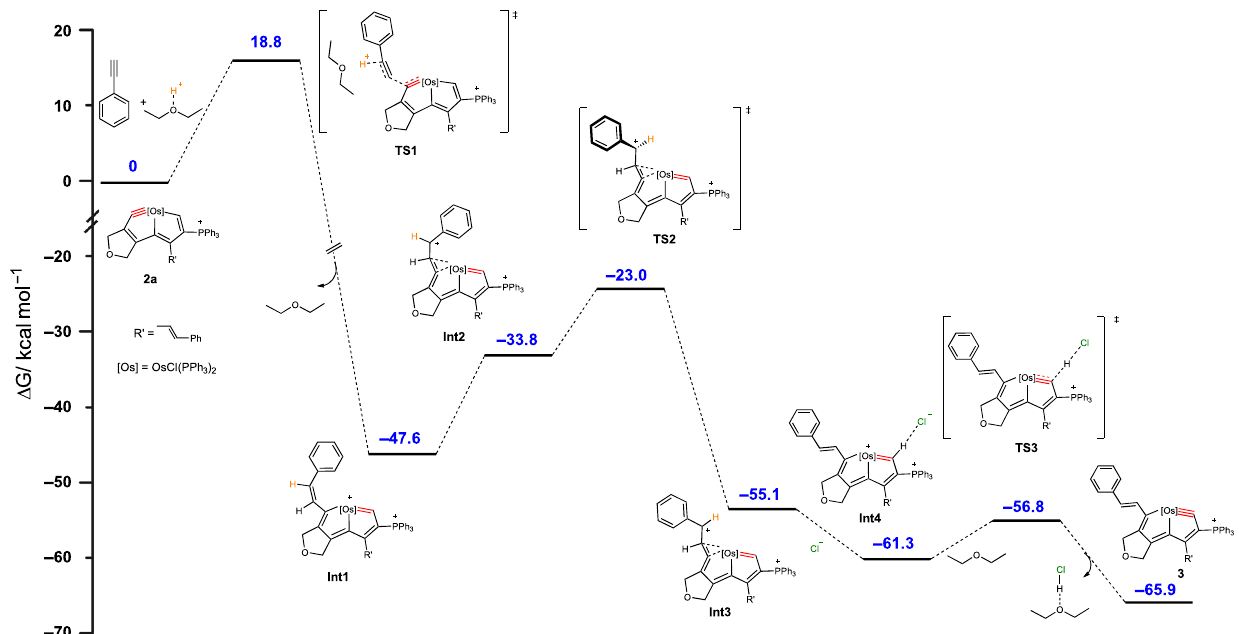
Fig. 3 Gibbs free energy pro fi le for the DFT-calculated possible mechanism. The computed free energies are in kcal mol − 1